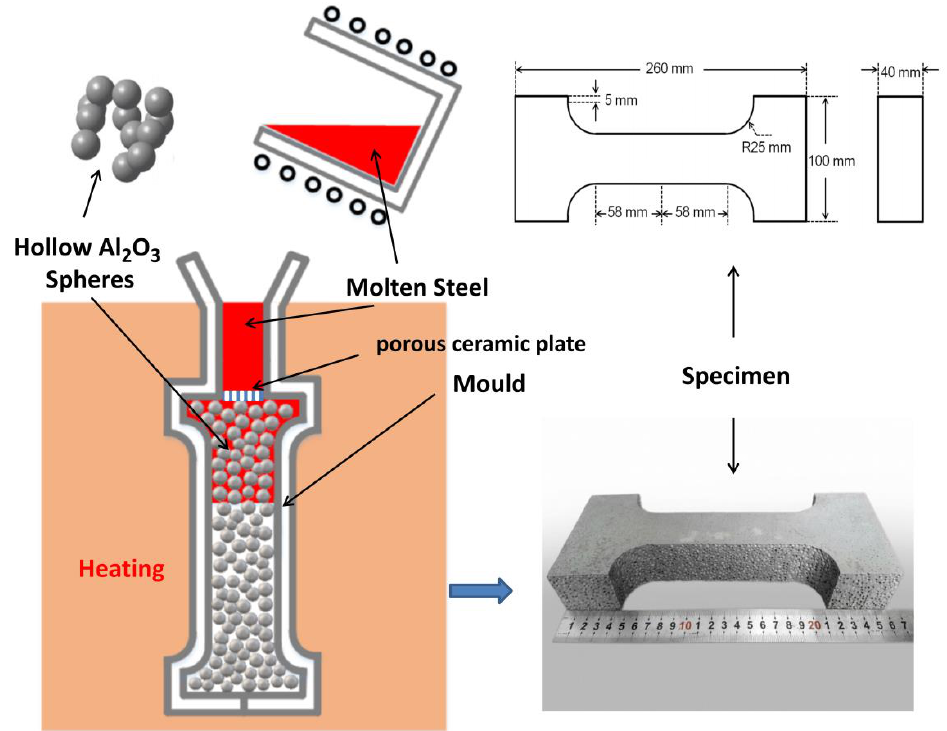
Figure 1. Schematic illustration of the infiltration and the tensile specimen.